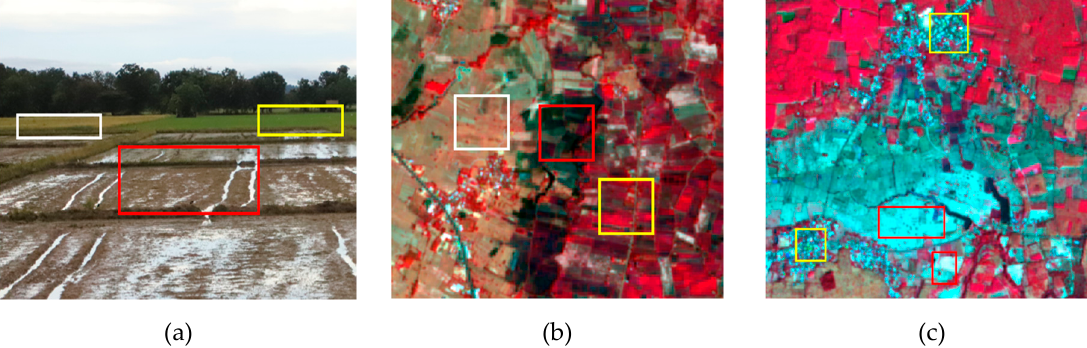
Figure 6. The complex spectral characteristics of land cover types in the study area. ( a ) Rice growing at different stages. The red, yellow and white color rectangles denote flooding, growing, and maturing phases. ( b ) Different spectral reflectance of rice at different stages. ( c ) Similar spectral reflectance between fallowed farmlands (red color rectangles) and impervious surfaces (yellow color rectangles).